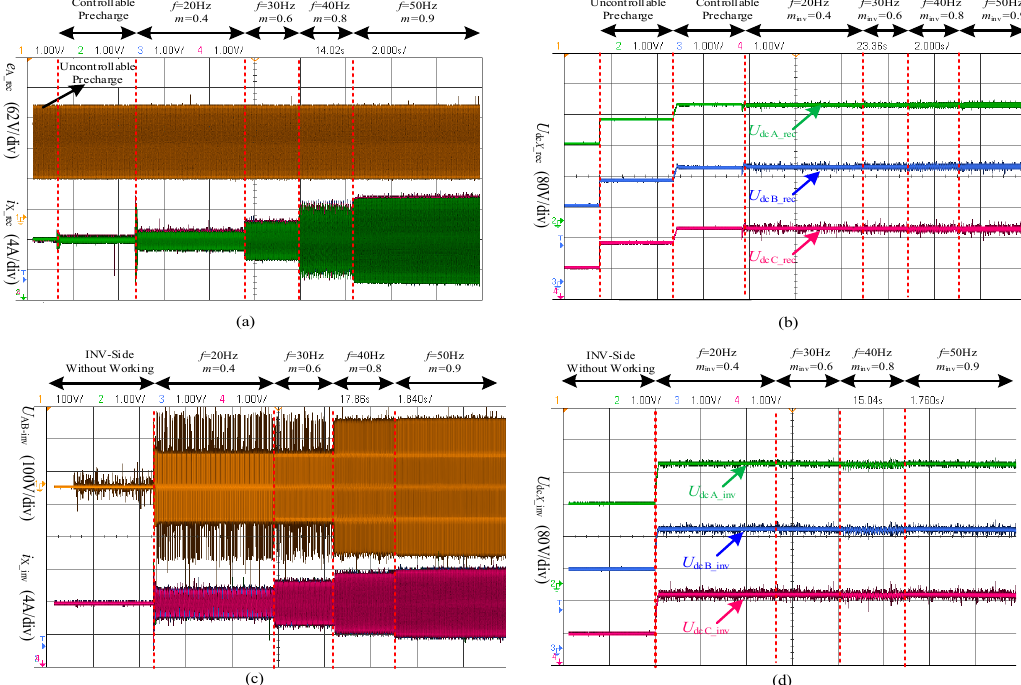
Figure 11. Experimental results of the whole working-process in transient-state condition; ( a ) Input voltage–current waveforms, e A_rec and i X _rec ; ( b ) voltages of C X _rec ; ( c ) output voltage–current waveforms, u AB_inv and i X _inv ; ( d ) voltages of C X _inv .